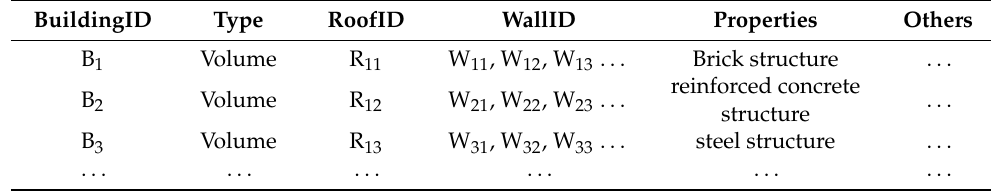
Figure 8. DBM-based generation for multiple-building T 2 OM and merged DTM-based and DBM- based T 2 OM. Table 6. Building relationships.